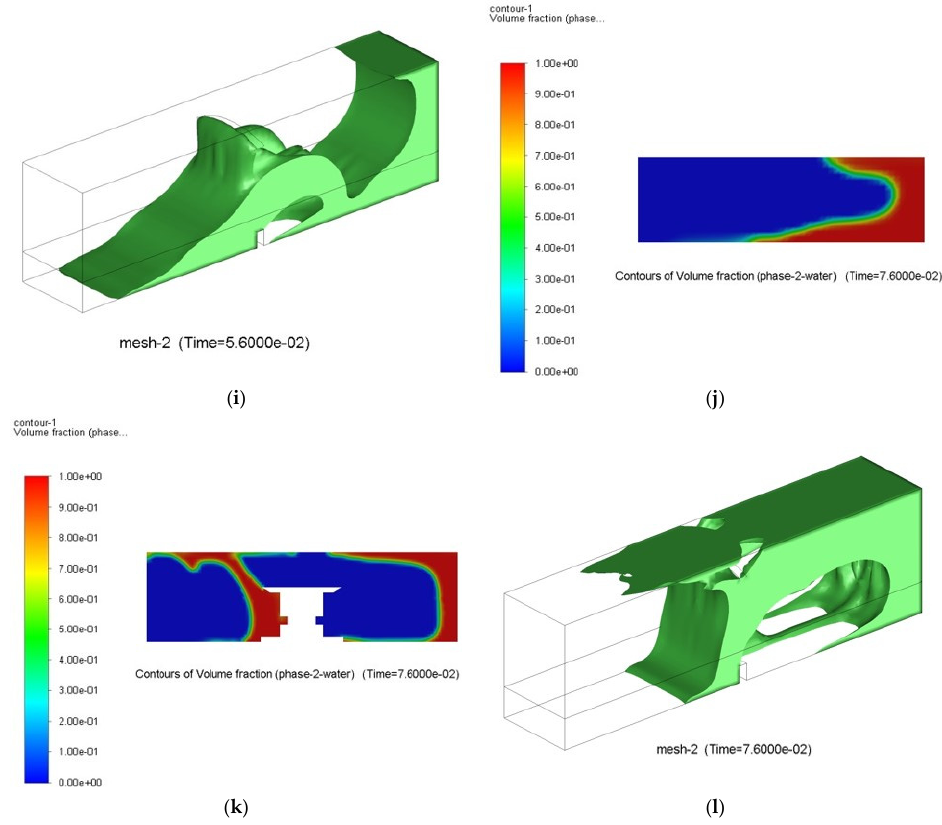
Figure 6. Comparison of the volume fraction results snapshots at various times under 25% filling; ( a , d , g , j ) Unbaffled tank, ( b , e , h , k ) Baffled tank with imperforate baffle, ( c , f , i , l ) Baffled tank with perforated baffle.